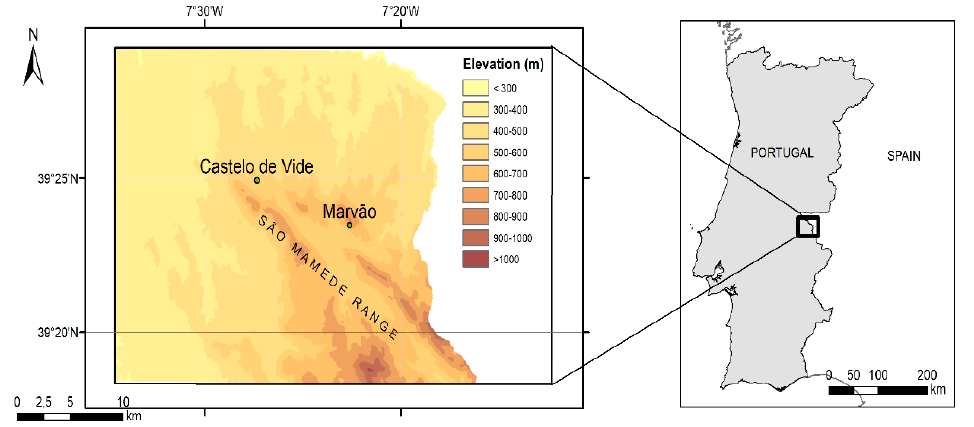
Figure 1. Location of the Marvão productive chestnut study area.